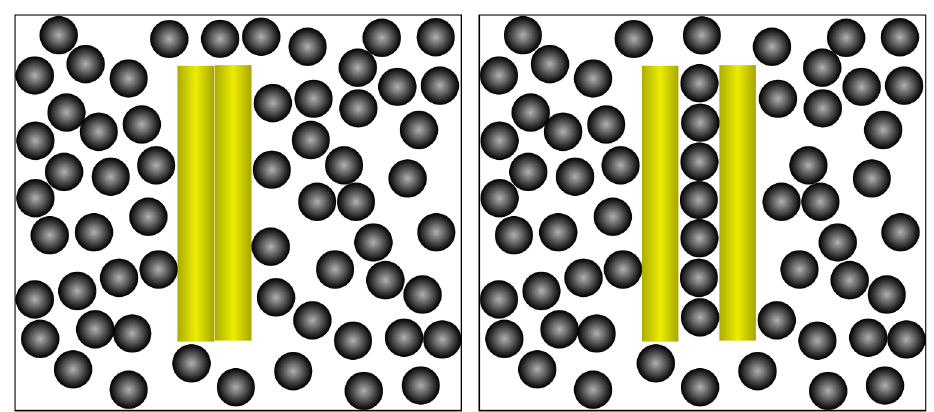
Fig 2. (Left) Dimer formed by direct excluded-volume forces, producing a “ direct depletion aggregate ” (DDA). (Right) Configuration formed by indirect depletion forces, giving rise to an “ indirect depletion aggregate ”